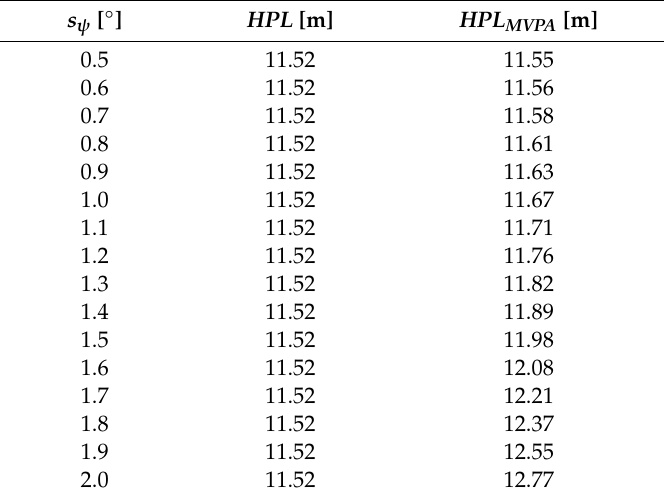
Table 1. HPL for various heading errors